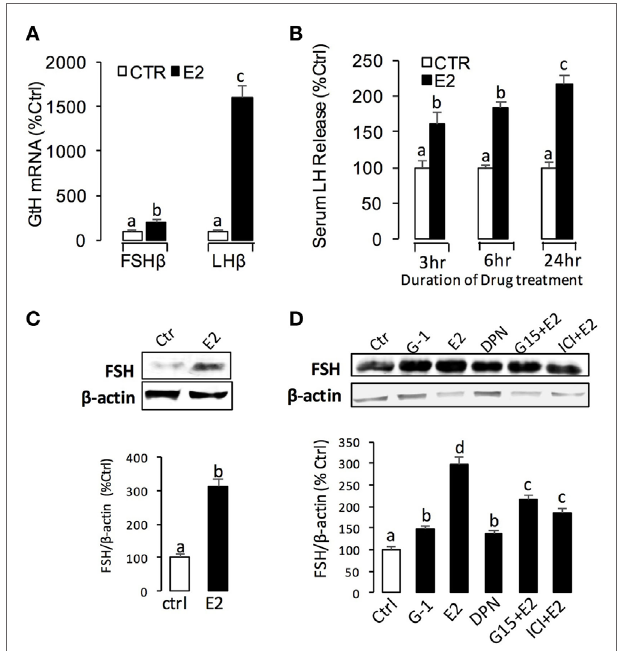
FigUre 6 | E2-induced luteinizing hormone (LH) and follicle-stimulating hormone (FSH) secretion and mRNA expression in grass carp. (a) In vivo effects of E2 on LH β and FSH β mRNA expression in grass carp pituitary. (B) E2-induced serum LH secretion in prepuberty grass carp. (c) Effect of E2 on FSH secretion in the serum of prepuberty grass carp. The quantified graph is shown below the representative blots in each group. Data presented are expressed as mean ± SEM ( n = 3). (D) Receptor specificity of E2-induced FSH synthesis in grass carp pituitary cells. The quantified graph is shown below the representative blots in each group. Data presented are expressed as mean ± SEM ( n = 3).